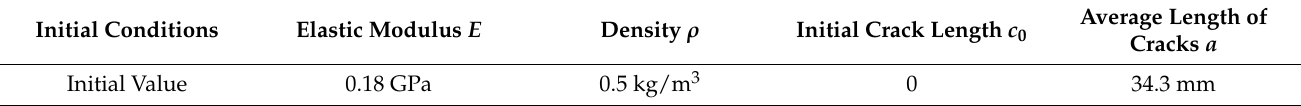
Table 3. The initial conditions for calculating the crack expansion rate of walnuts.